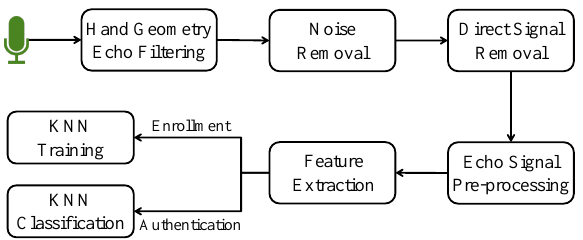
Figure 5. Hand geometry receiver design.